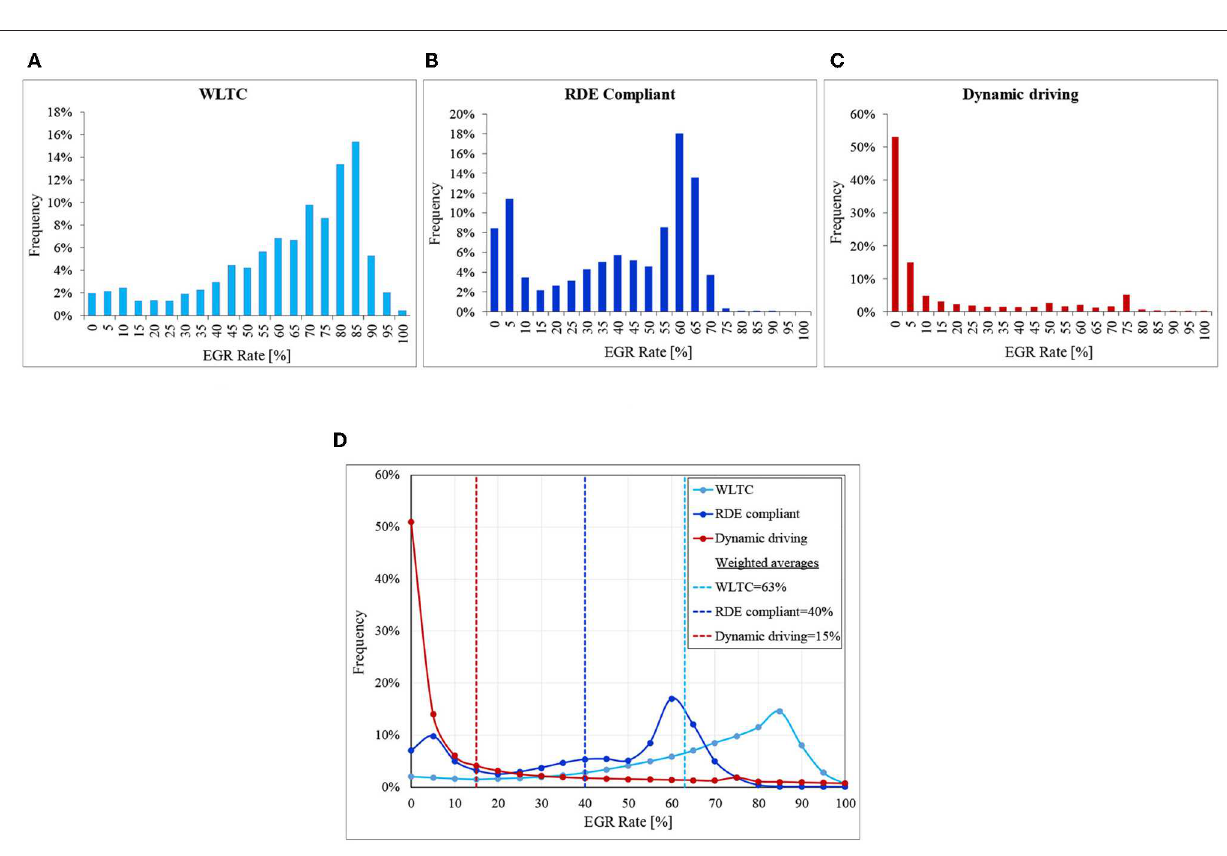
FIGURE 9 | EGR rate of Vehicle 1 under the different driving conditions. Histograms (A–C) and approximate distributions (D) during each test cycle.